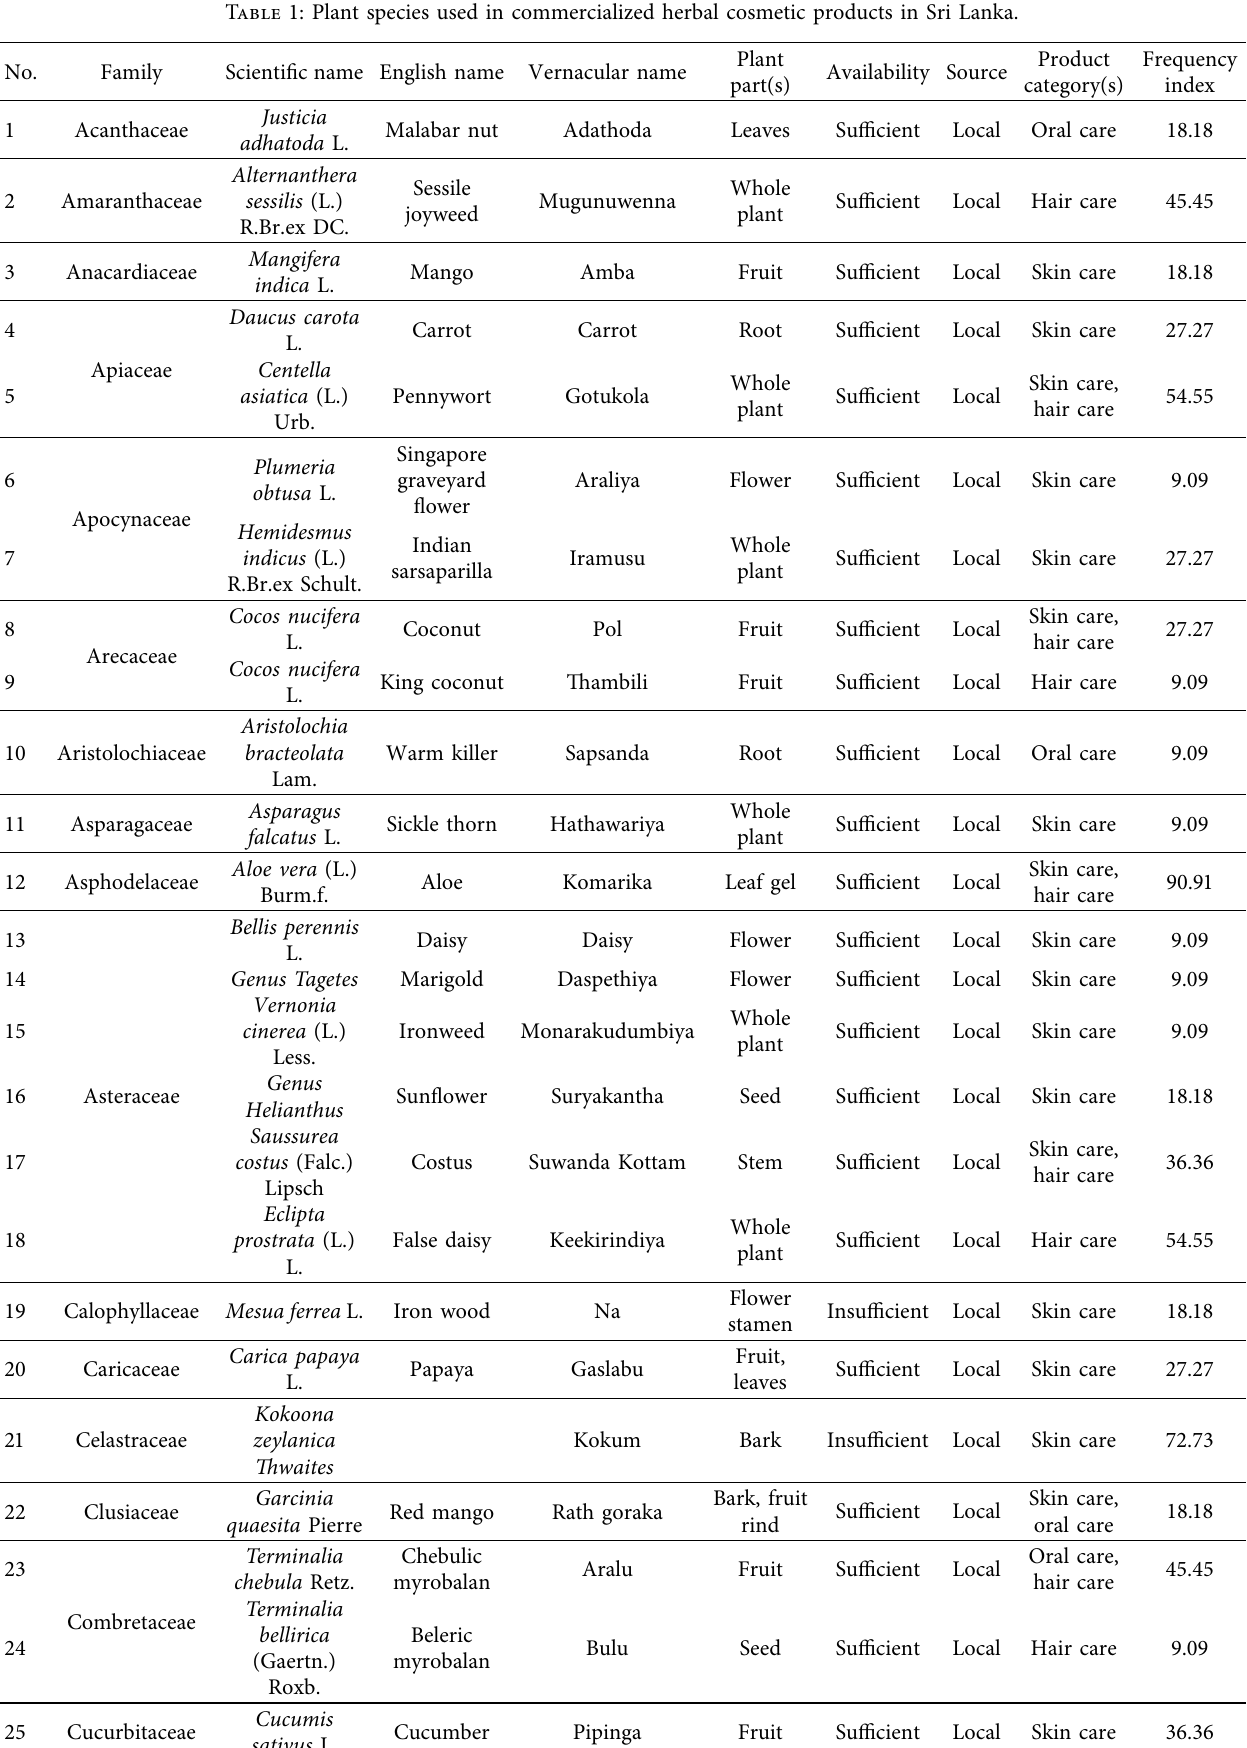
Table 1: Plant species used in commercialized herbal cosmetic products in Sri